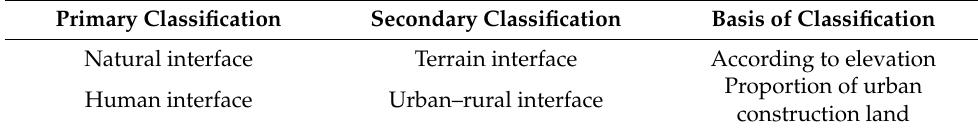
Table 3. Types of spatial interfaces in Zhulin and the basis of